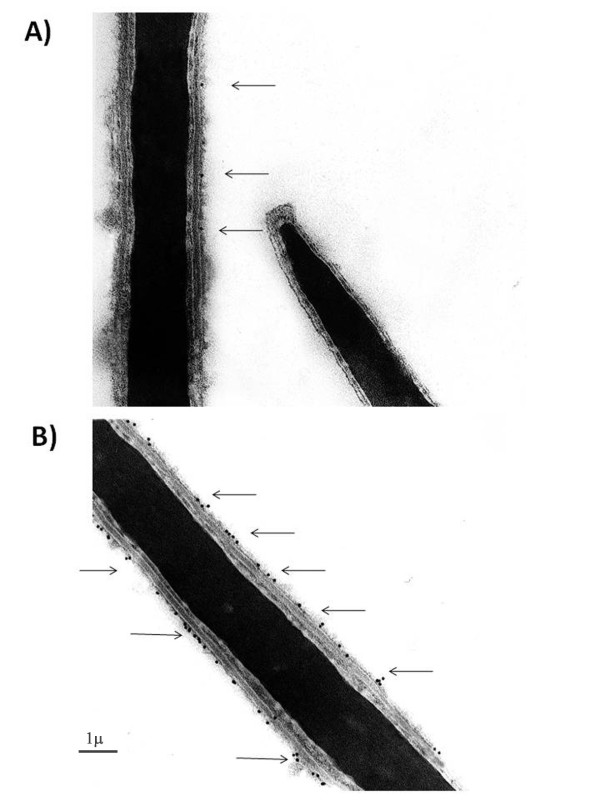
Transmission electron microscopy pictures demonstrating the topography of capacitation-dependent PLCγ1 relocalization. Transmission electron microscopy pictures (30.000X) showing: panel A): ejaculated spermatozoon displaying few gold particles (arrows) indicative of a low localization of PLCγ1 protein over cell membranes. panel B): in vitro capacitated spermatozoon incubated in the presence of CD that localized on its membrane several gold particles (arrows).